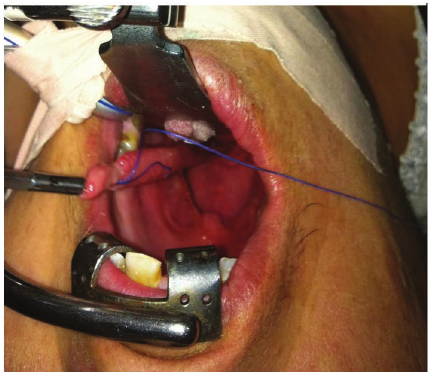
Figure 1: View of giant fibrovascular polyp originating from hypo- pharynx.